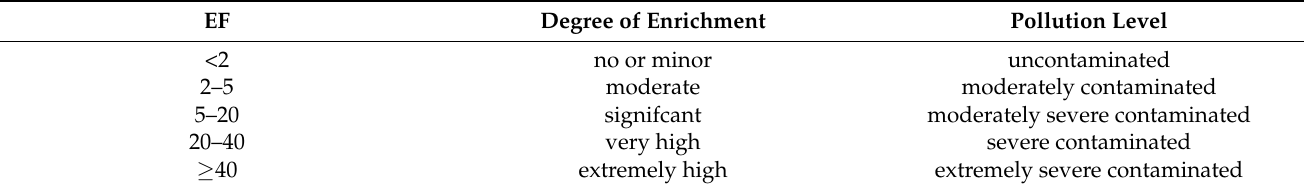
Table 3. The enrichment factors and pollution